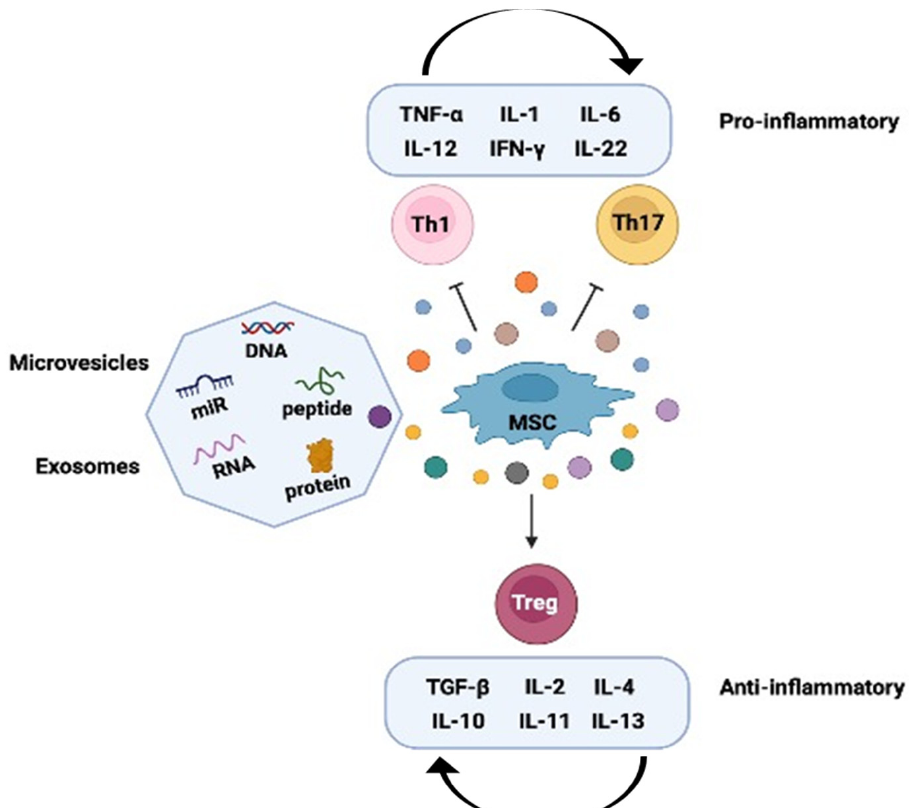
Figure 6. Immunomodulation by mesenchymal stem cells (MSCs) in vitiligo. MSCs have been shown to have immunomodulatory e ff ects in vitiligo. The mechanisms of MSC-mediated immunomodulation are complex and involve both cell-cell contact-dependent mechanisms and the secretion of various soluble mediators. These mediators can a ff ect the activity of regulatory T cells (Tregs), T helper 1 (Th1) cells, T helper 2 (Th2) cells, T helper 17 (Th17) cells, dendritic cells (DCs), and natural killer (NK) cells. The mediators include interleukins (ILs), interferon-gamma (IFN- γ ), tumor necrosis factor-alpha (TNF- α ) and transforming growth factor-beta (TGF- β ). Figure was created using Biorender.